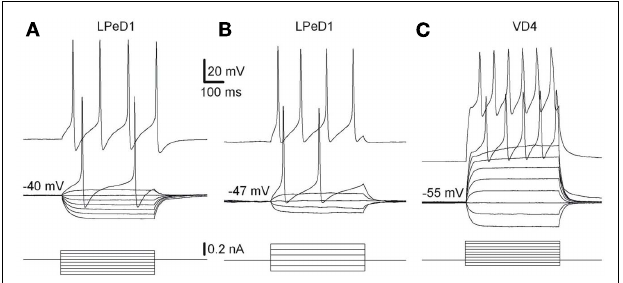
FIGURE 6 | Physiological properties of LPeD1 andVD4 neurons recorded with Si and PI chips. Voltage responses to a series of intracellular current pulses of an LPeD1 (A) and aVD4 neuron (C) recorded using Si chips.The current pulses were applied at rest, − 40 and − 55mV for LPeD1 andVD4, respectively. (B) Voltage responses to a series of intracellular current pulses of an LPeD1 neuron recorded using PI chips.The current pulses were applied at rest, − 47mV. From Martina et al.